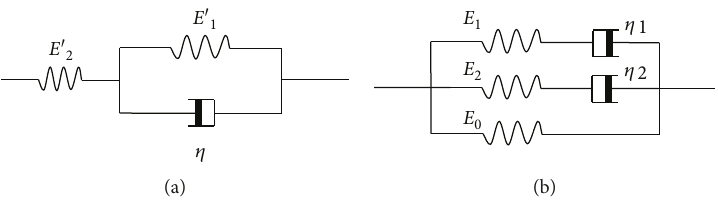
Figure 6: Schematic representation of the three-element model (a) and the Maxwell-Wiechert model (b).